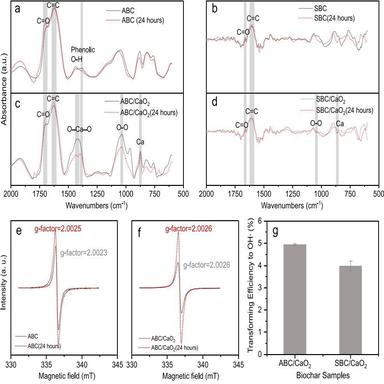
Chemical changes on biochar surface before and after reaction. The FT-MIR spectra of ABC (a), SBC (b), ABC/CaO2 (c) and SBC/CaO2 (d) before and after 24 h batch experiment for tebuconazole removal. EPR spectra for e) ABC and SBC and f) ABC/CaO2 and SBC/CaO2 before and after 24 h of reaction. g) The transforming efficiency of CaO2 to hydroxyl radicals.